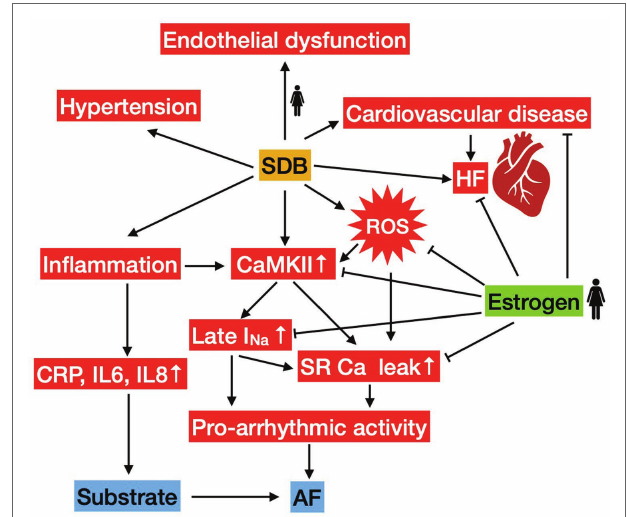
FIGURE 1 | Gender-related mechanisms in sleep-disordered breathing (SDB). Stimulating pathways are depicted by arrows, protective/inhibitory effects of estrogen are denoted with a perpendicular line at the end. SDB leads to an increased risk of heart failure (HF), hypertension, endothelial dysfunction (in women), cardiovascular disease, inflammation, production of reactive oxygen species (ROS), and increased CaMKII activity. CaMKII- mediated SR Ca leak and Late I Na facilitate pro-arrhythmic activity serving as trigger for atrial fibrillation (AF). Increased inflammation serves as part of the pro-arrhythmic